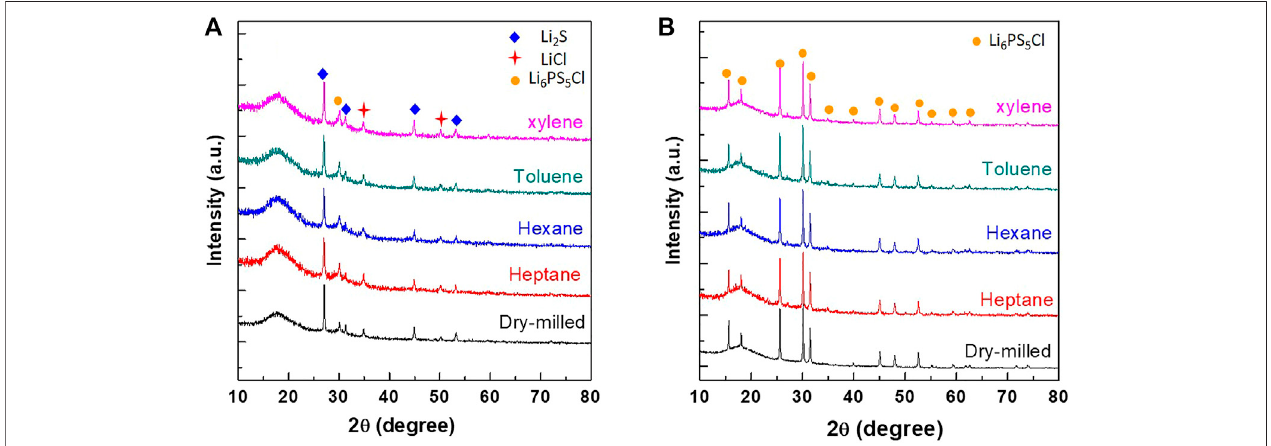
FIGURE 1 | XRD patterns of dry- and wet-milled (hexane, heptane, toluene, and xylene) powder samples (A) before and (B) after post-annealing at 550 ° C for 4 h.